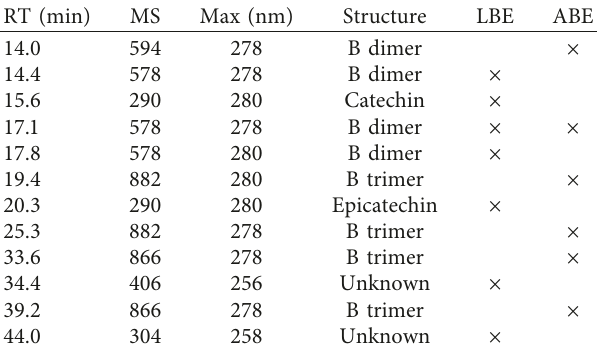
Table 1: Components identified in ABE and LBE by